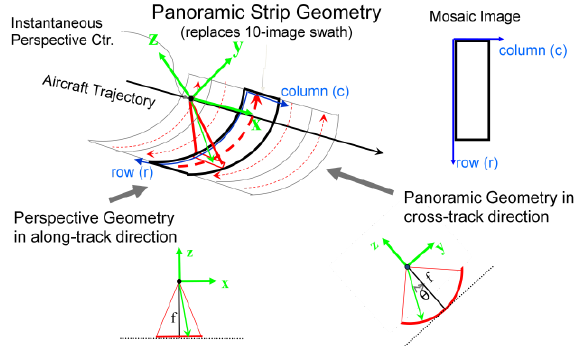
Figure 3. Panoramic geometry applied to 10-image scan from a GH